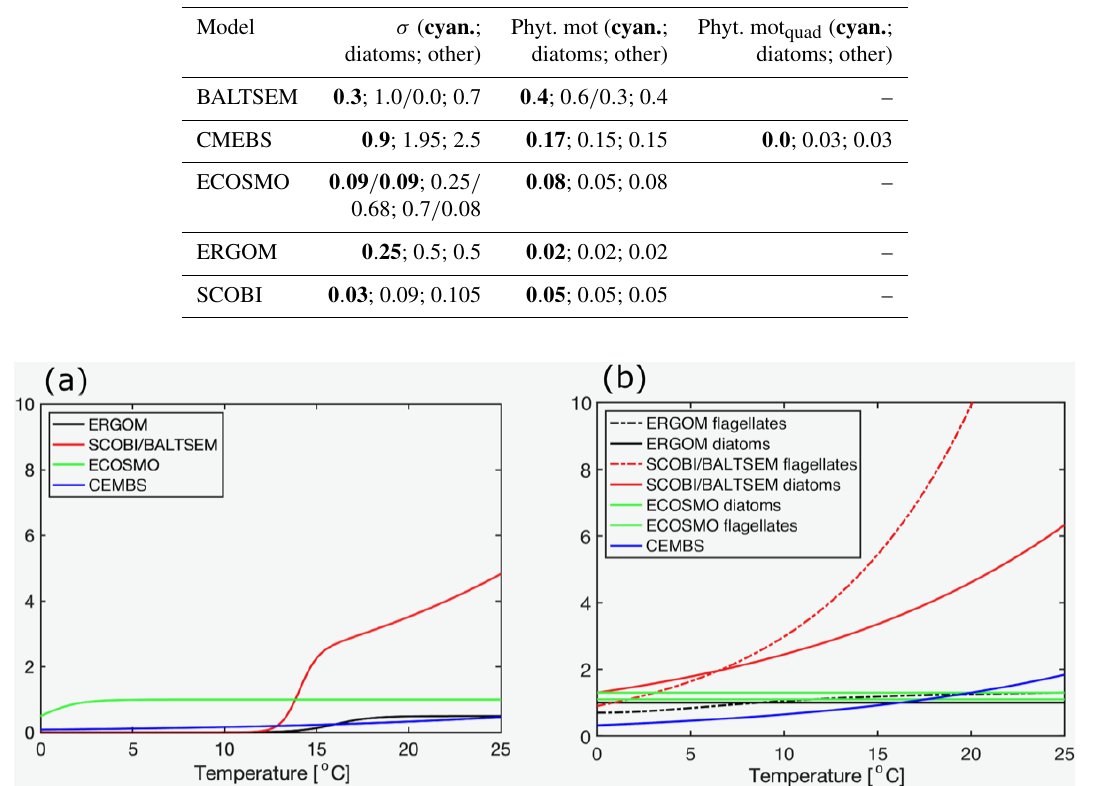
Table 4. Model parameters that determine the termination of cyanobacterial blooms. Comparison among the models and respective param- eters of other functional groups. The phytoplankton mortality rates in BALTSEM depend on temperature and the environmental conditions. The provided values refer to 0 ◦ C. Also, the BALTSEM model uses different parameter values for diatoms in spring and autumn. The pro- vided values for σ for the ECOSMO and SCOBI models result from the product of max. zooplankton growth rate and food preference for the respective phytoplankton functional groups. The two values for the ECOSMO model refer to their two zooplankton groups: macro- and micro-zooplankton. The quadratic mortality for the CEMBS model was unit converted relative to the original values.